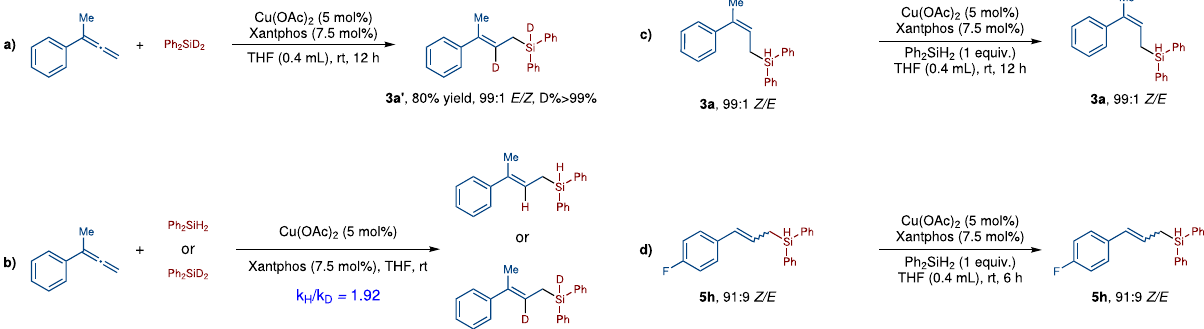
(cid:2) E ( (cid:3) - (cid:3) ) = -0.1 22-ts 23-ts (cid:2)(cid:2) G ‡ = 0.0 (cid:2)(cid:2) G ‡ = 1.3 (cid:2)(cid:2) G ‡ = 1.7